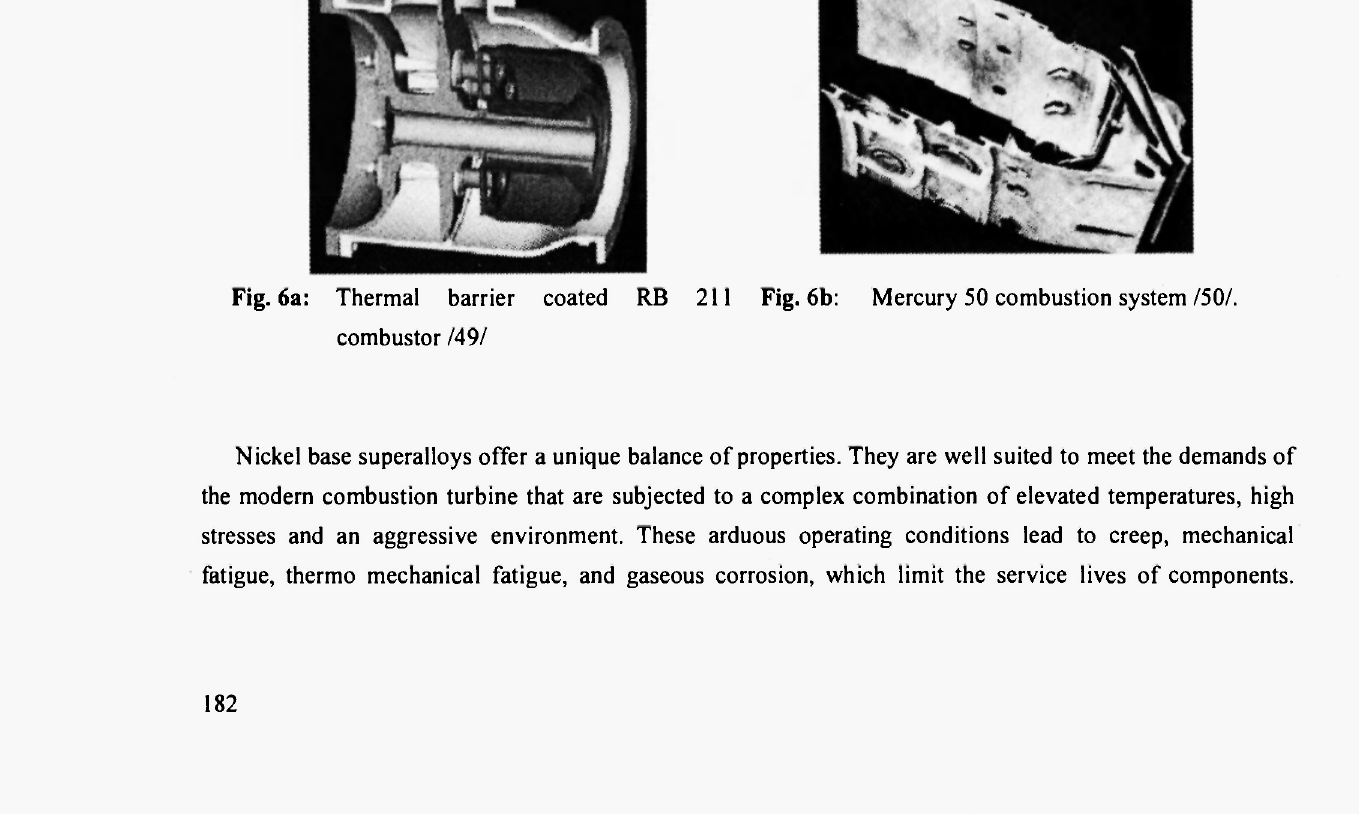
Fig. 6a: Thermal barrier coated RB 211 Fig. 6b: Mercury 50 combustion system /50/. combustor